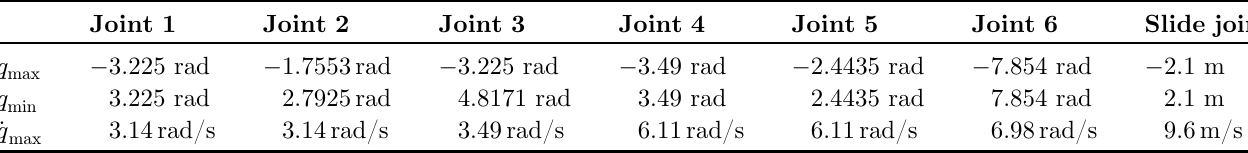
Table 1. Fanuc M20iA/35M joint limits.